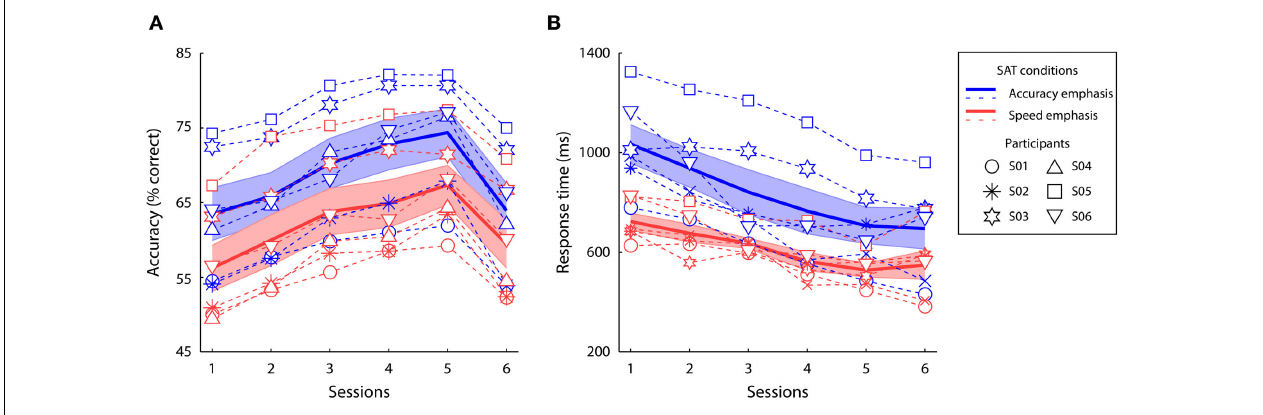
areas indicate the mean performance and the standard errors across participants. Different markers indicate performance of each individual participant across